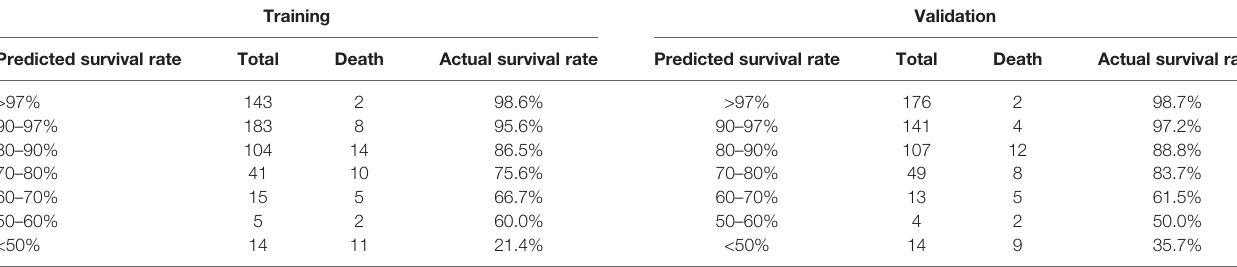
TABLE 3 | Comparison of 5-year predicted survival rate and actual survival rate. Training